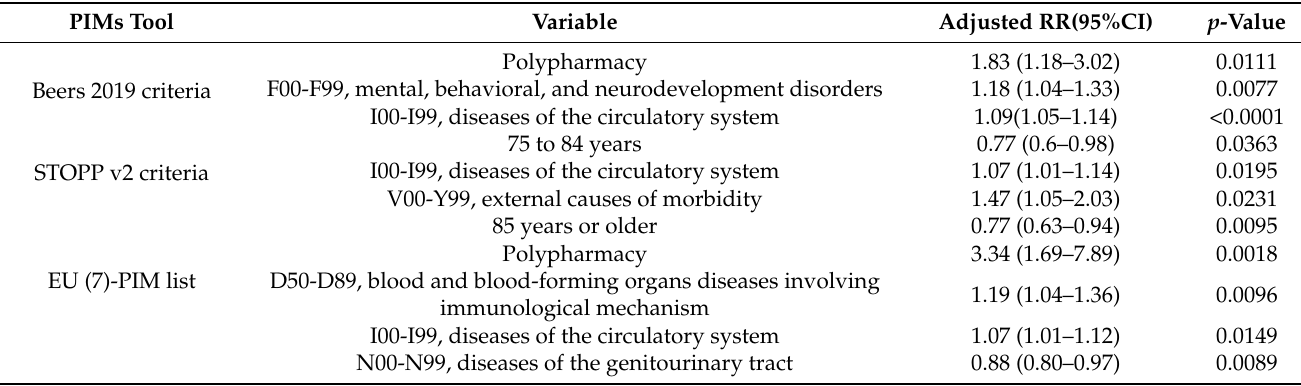
Table 5. Factors associated with PIM prevalence at